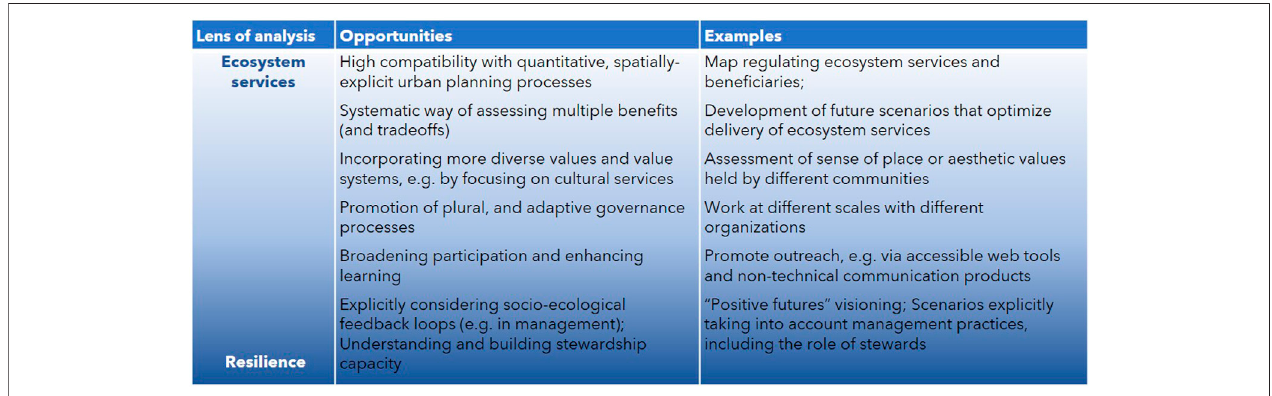
FIGURE 2 | Opportunities (realized and potential) to support natural infrastructure planning, identi fi ed by using ecosystem services and resilience lenses. The distinction between the lenses does not mean that these opportunities are mutually exclusive. On the contrary, using one lens or the other allows leveraging of opportunities offered by both fi